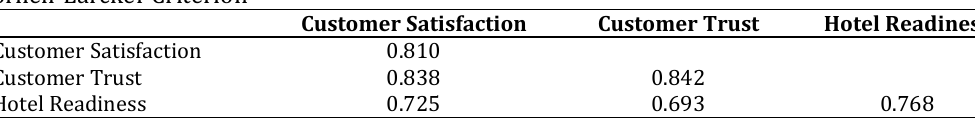
Table 6: Discriminant validity for international chain hotel Fornell-Larcker